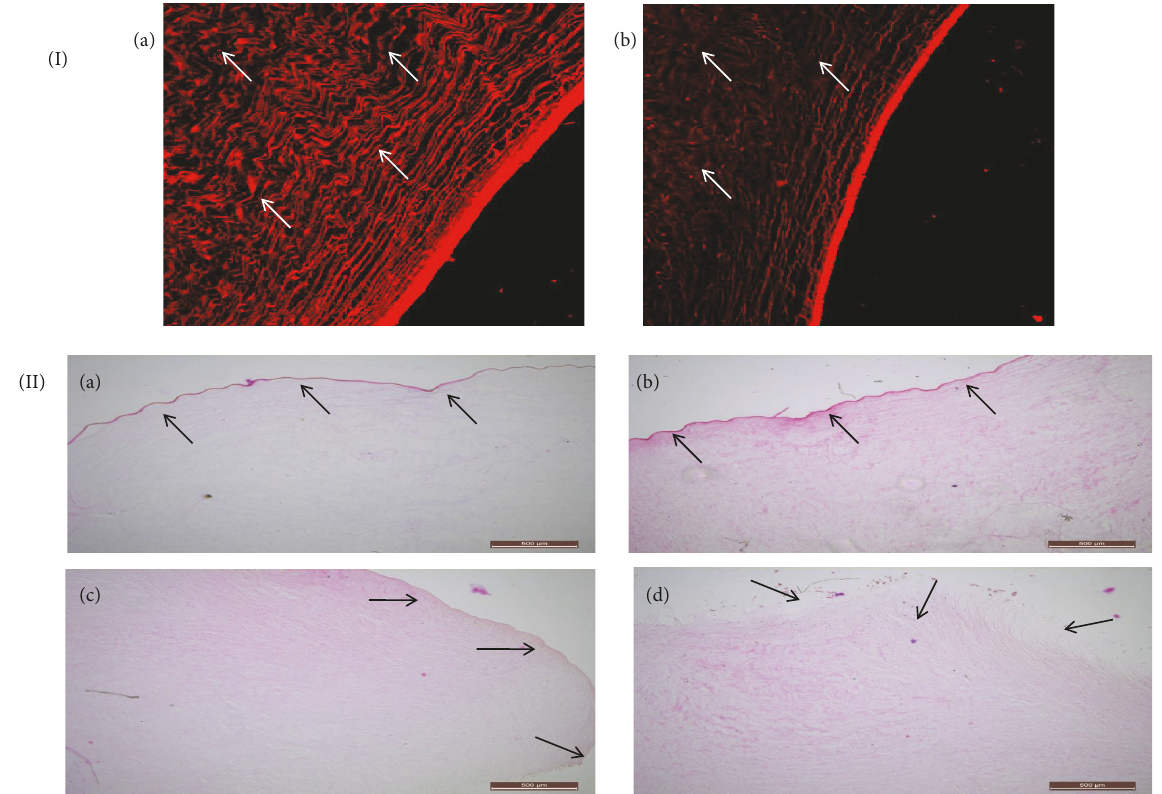
Figure 7:(I) CSLM imageof rhodamine6G loaded (a)FX-CH-Rdnanoparticles;(b)Rd solution; thearrows indicatethedepth of penetration of rhodamine 6G; (II) cross section of cornea treated with (a) optimized formulation; (b) marketed formulation; (c) phosphate buffer saline (negative control); (d) sodium dodecyl sulfate (positive control); the arrows indicate the presence of intact corneal layers in (a), (b), and (c) and disrupted corneal layers in (d).